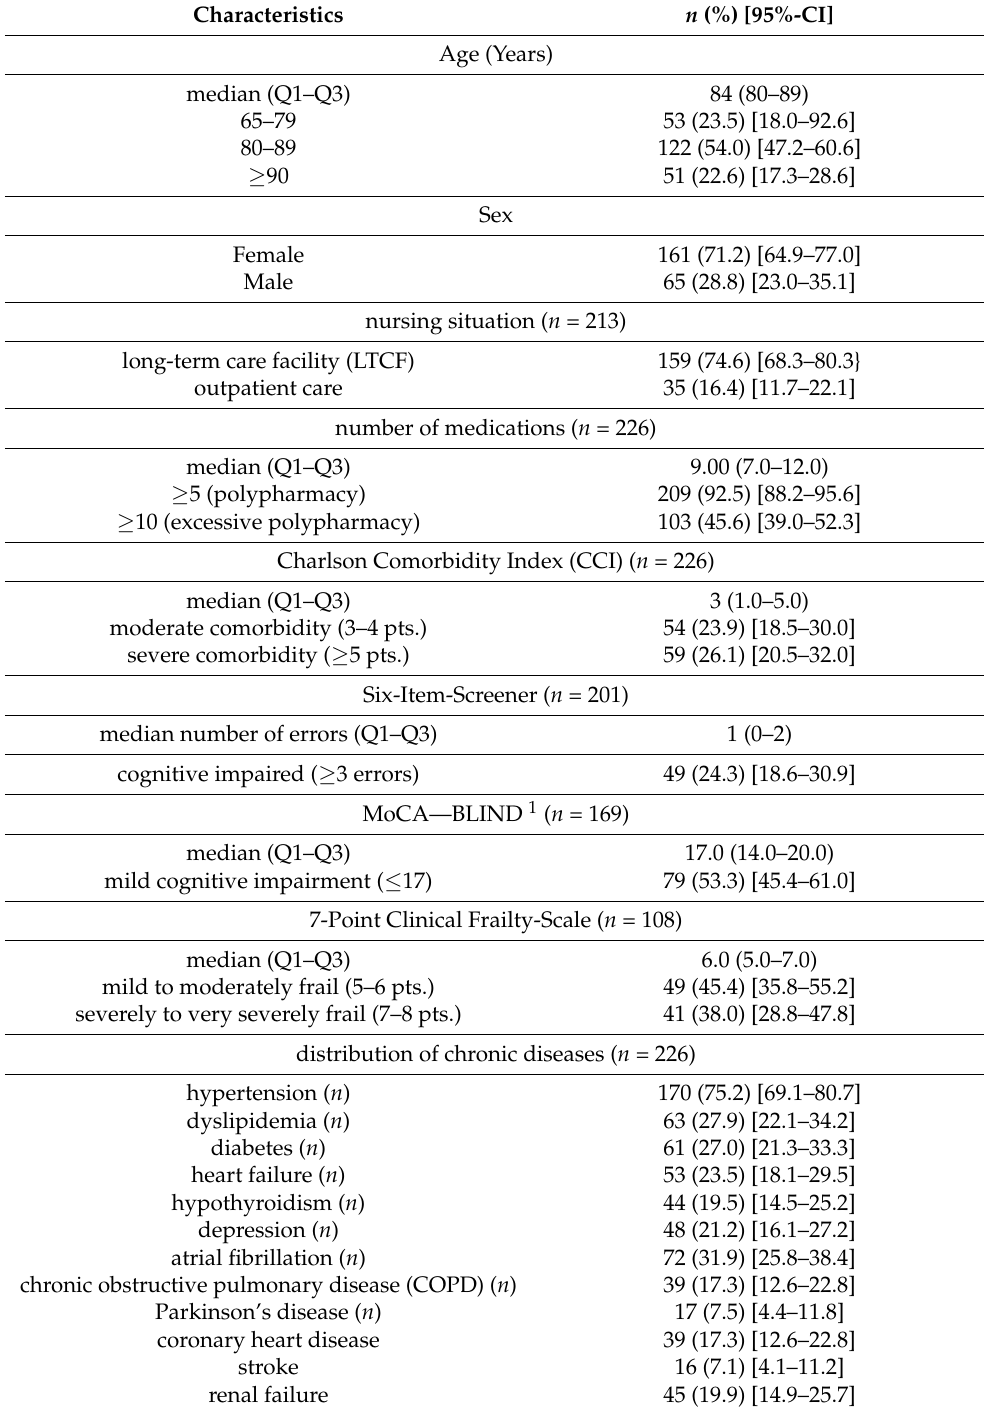
Table 2. Baseline characteristics of the study population ( n =